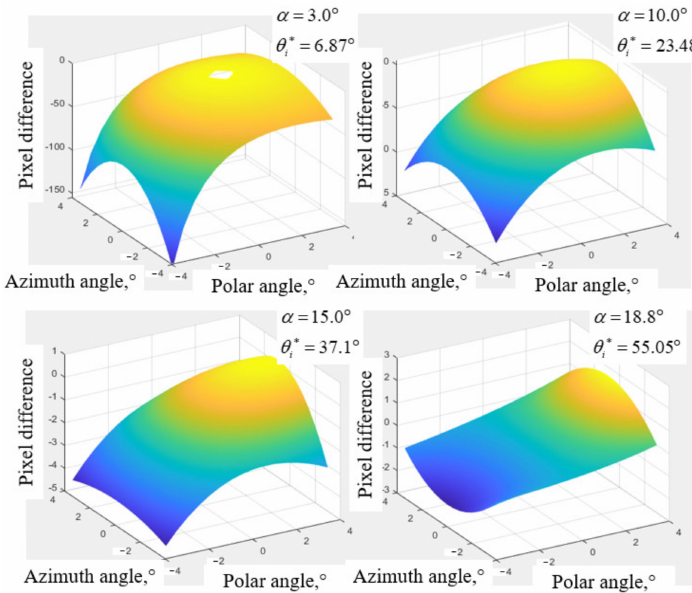
Figure 6. Aberrations of different ultrasonic cut angles of